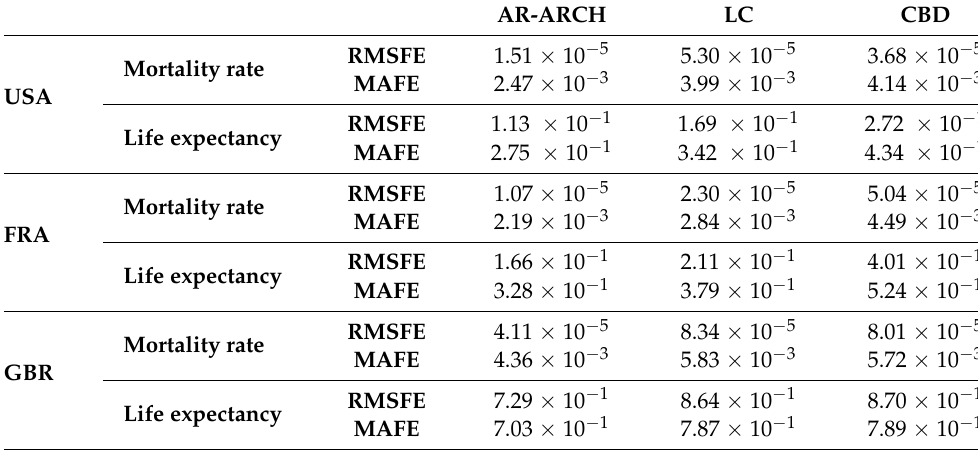
Table 3. Point forecast accuracy: Forecast average errors between the LC, AR-ARCH, and CBD (see [6]) two-factor model both for mortality rates and life expectancies over the period of